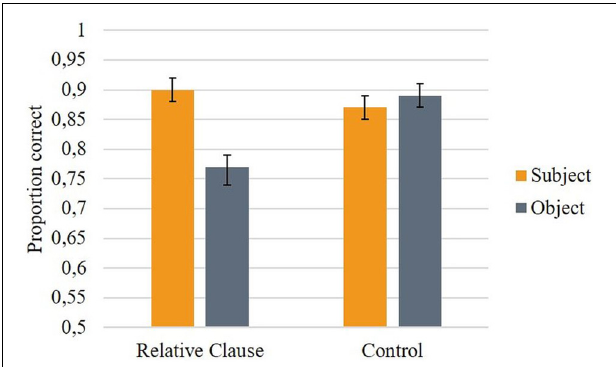
FIGURE 2 | Mean proportion of correct responses per condition (bars represent 95% confidence interval).